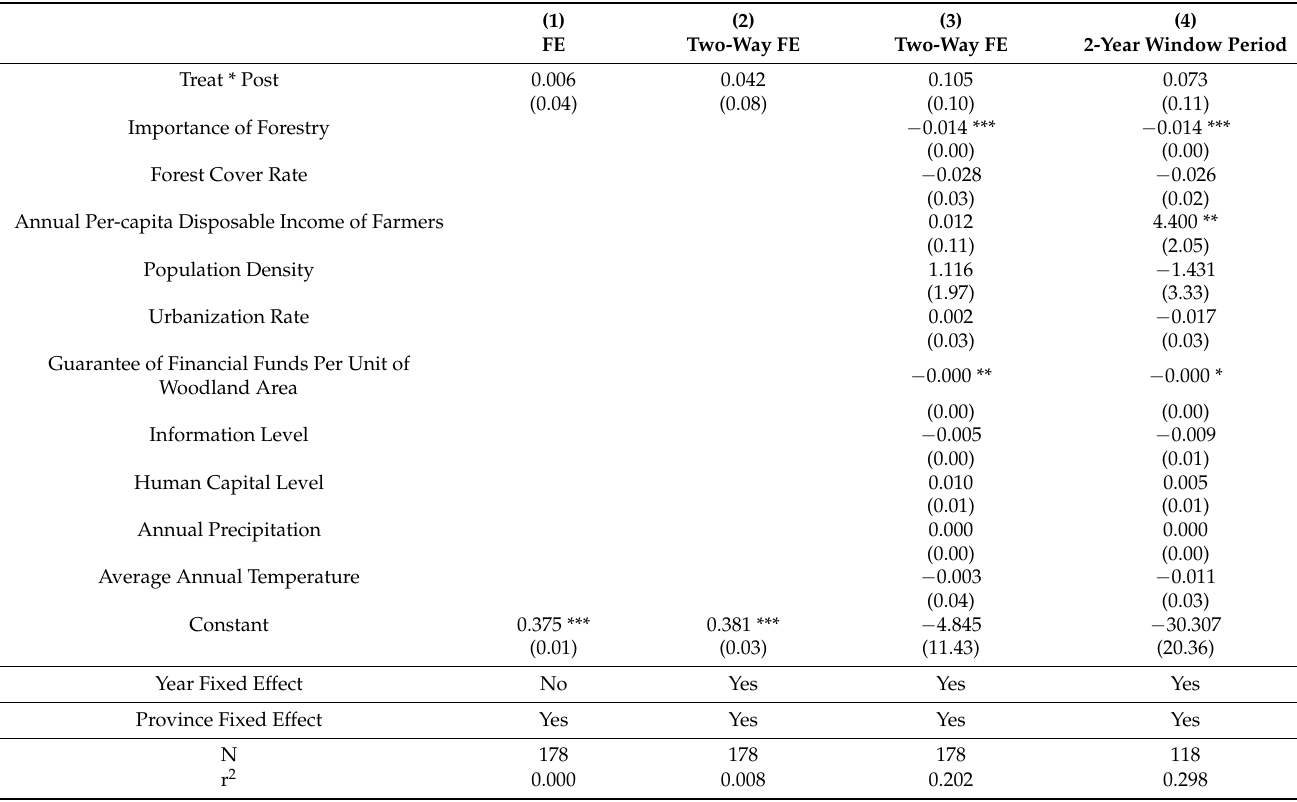
Table 7. Fixed-effects regression model: heavily damaging forest fires and